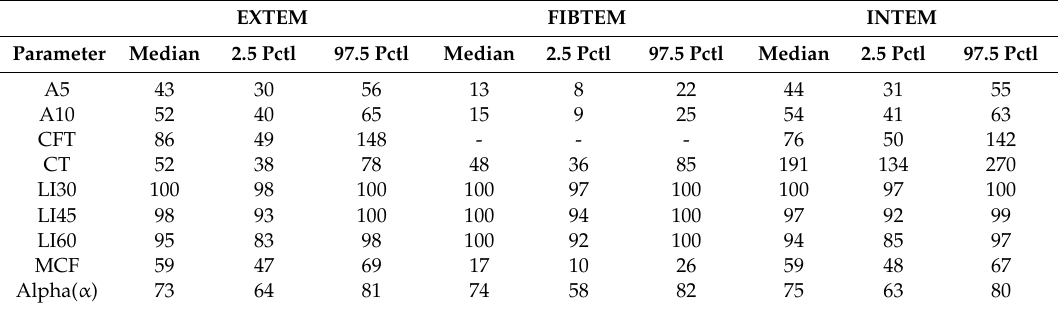
Table 2. Reference ranges of the ROTEM parameters ( N = 215 term